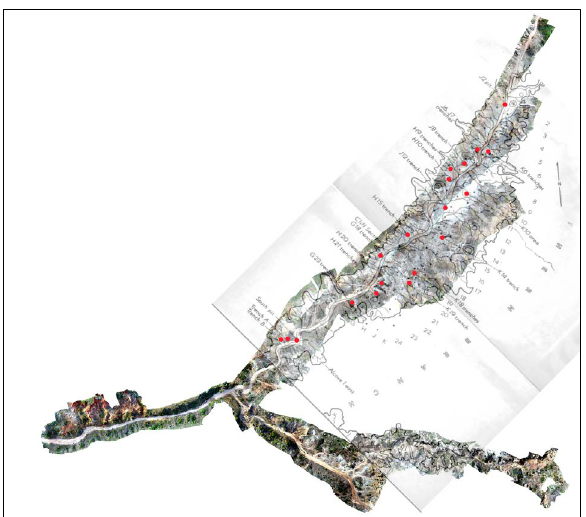
Figure 6: Orthomosaic overlaid with previous map by Howell et al. 4 Approximate locations of previous excavation trenches are marked in red.